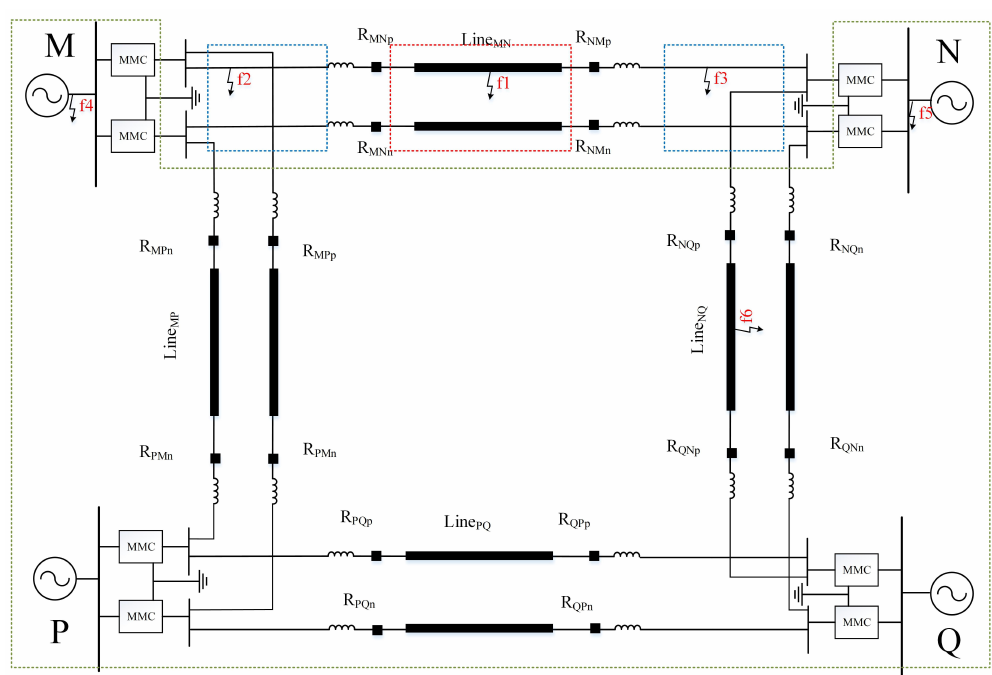
Figure 2. Line MN protection device action area.